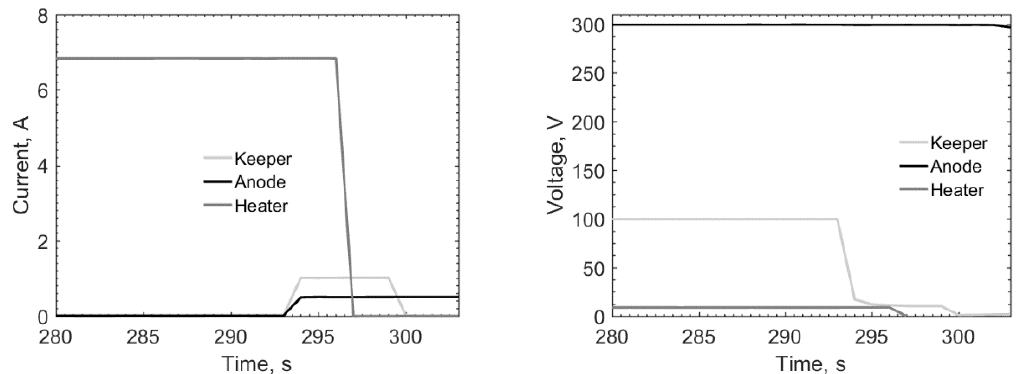
Figure 9. Thruster ignition sequence after the heating transient: currents (left) and voltages